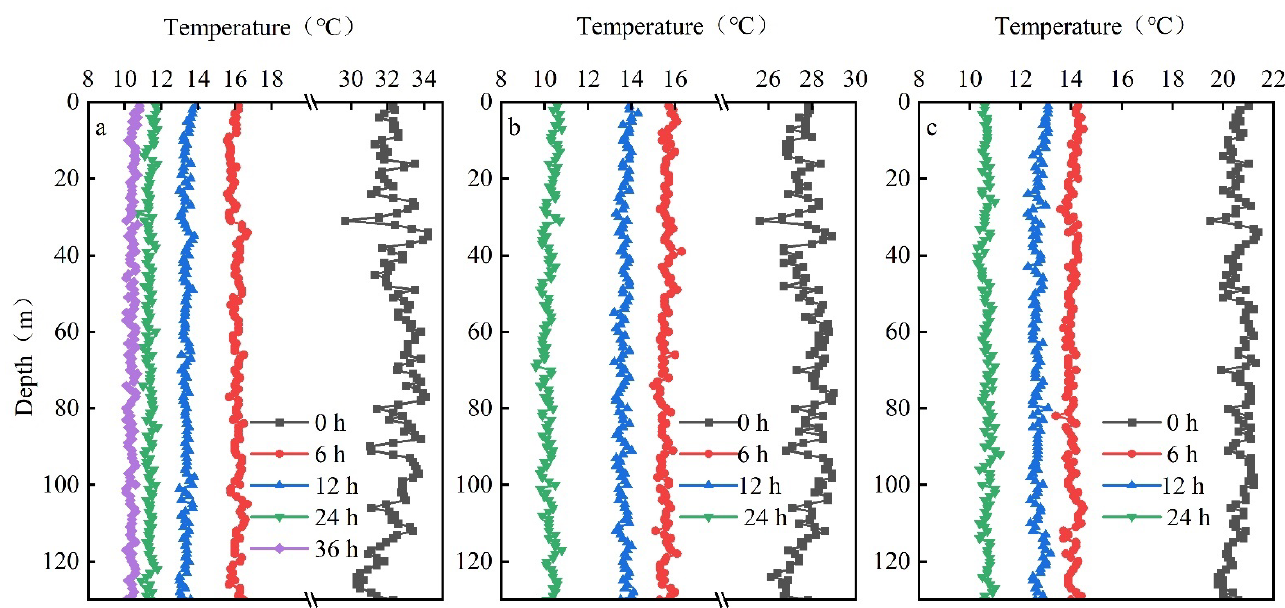
Figure 10. Formation temperature after stopping heating. ( a ) Condition R1. ( b ) Condition R2. ( c ) Condition R3.